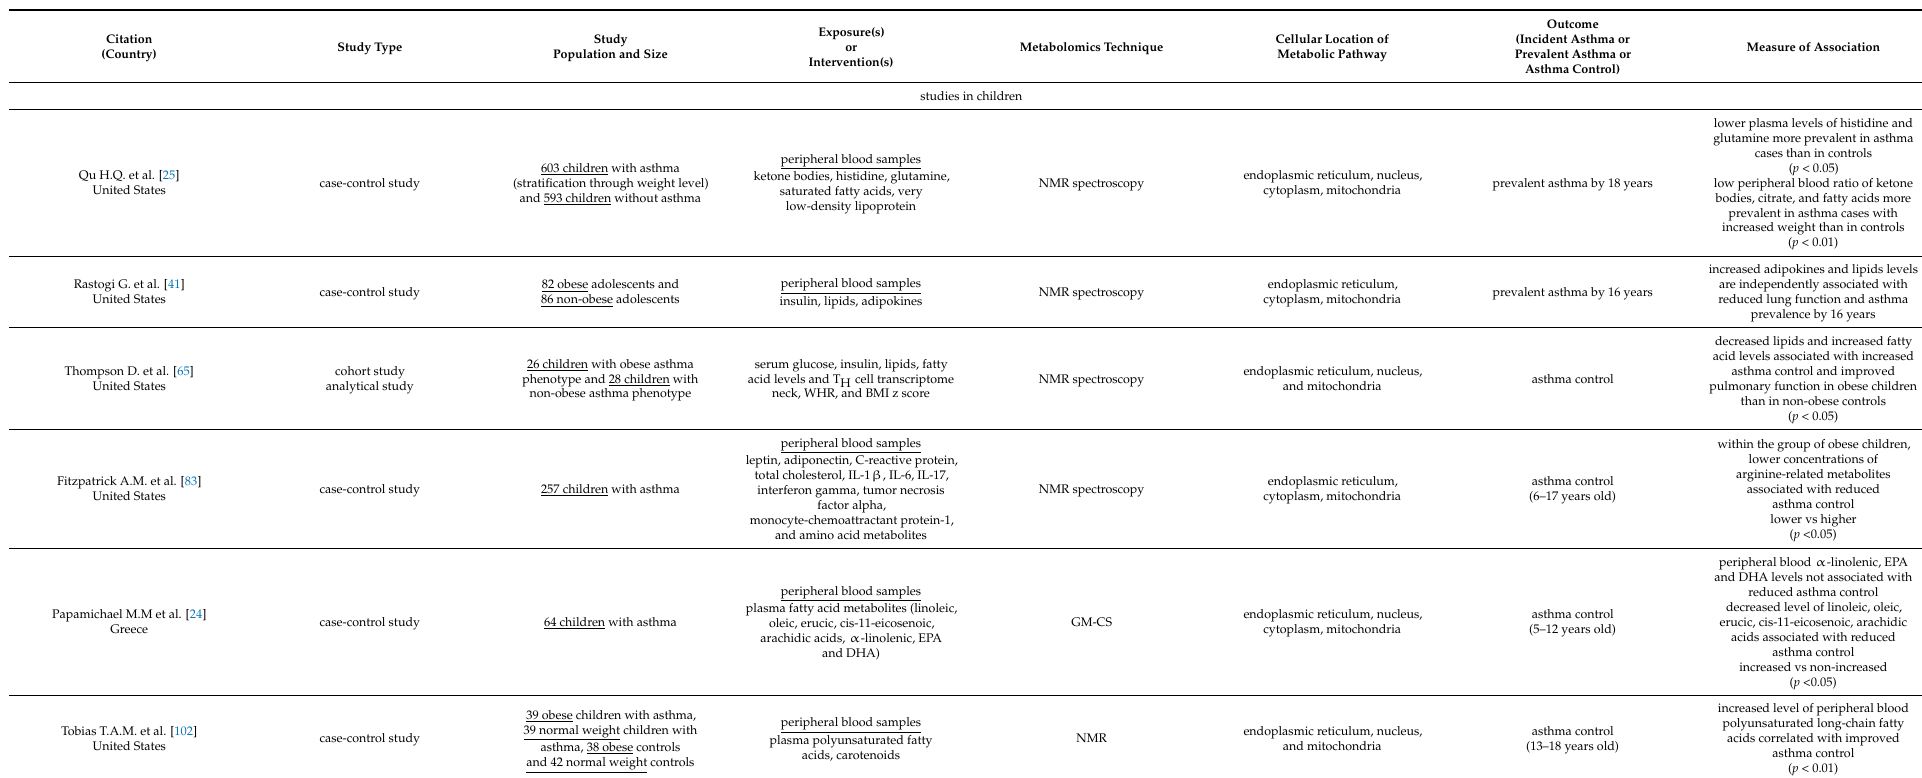
Table 1. Table describing metabolomics studies that have reported associations between childhood and adult asthma and